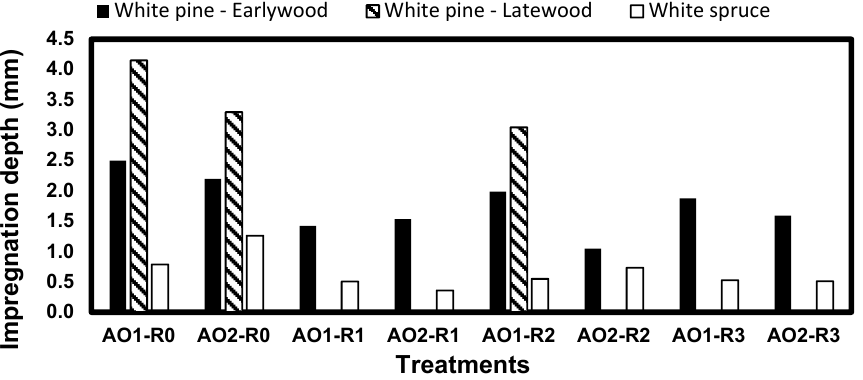
Figure 9. Impregnation depth of the indigo dye in the white pine (earlywood and latewood) and the earlywood of the white spruce.